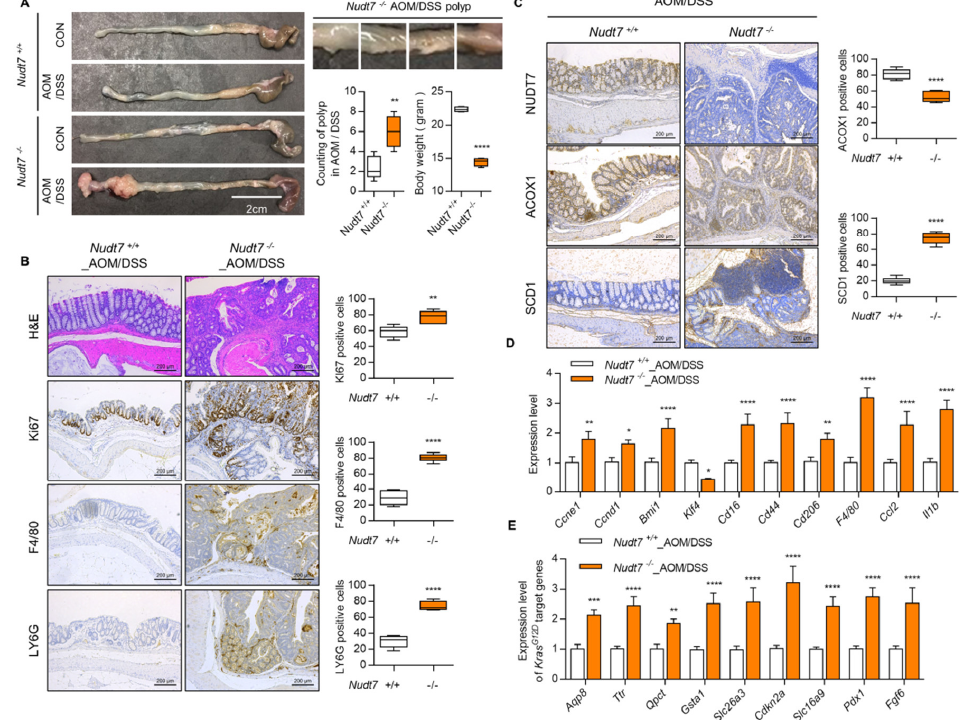
Figure 4. AOM/DSS (azoxymethane/dextran sulfate sodium) - treated Nudt7 −/− mice increases the Figure 4. AOM / DSS (azoxymethane / dextran sulfate sodium)-treated Nudt7 − / − mice increases the possibility of CRC development. ( A ) Mice were treated with AOM / DSS and polyp number was counted. Scale bars: 2 cm. ( B,C ) Immunohistochemistry with hematoxylin and eosin (H&E), Ki67, F4 / 80, LY6G, NUDT7, ACOX1, and SCD1 ( n = 4) and positive cells were counted for every 100 cells in 3 di ff erent fields at 100 × magnification in Nudt7 +/+ and Nudt7 − / − colons treated with AOM / DSS. Results are representative of at least 3 independent experiments. Scale bars: 200 µ m. ( D,E ) Transcriptional levels of proliferation and inflammatory marker genes and Kras G12D target genes in Nudt7 +/+ and Nudt7 − / − colons treated with AOM / DSS. Rn18s was used as an endogenous control. Results are representative